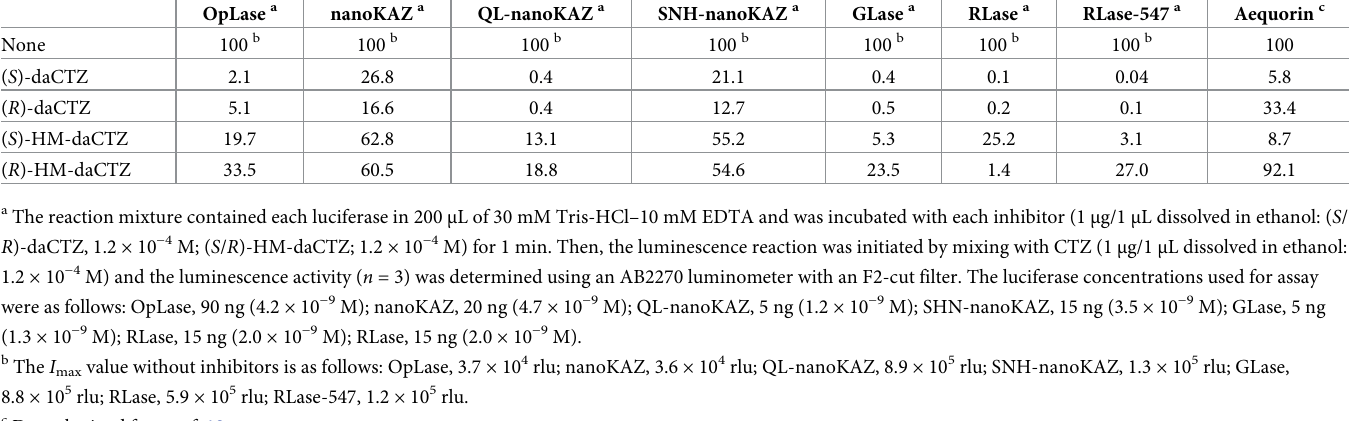
structure of QL-nanoKAZ was determined at 1.70 Å resolution (PDB ID: 7VSX). The statisti- cal values of data collection and structure refinement are summarized in Table 9 .